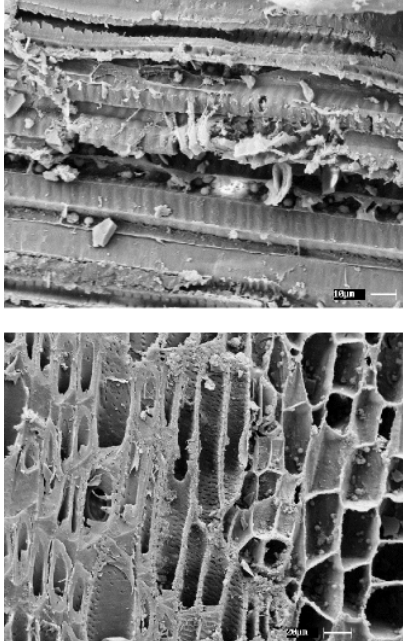
solutions.Figure 1. Vascular bundles in coffee tree stems grown in adequate (top) and deficient bottom B solutions. Observe xylem and phloem vessel discontinuities in deficient